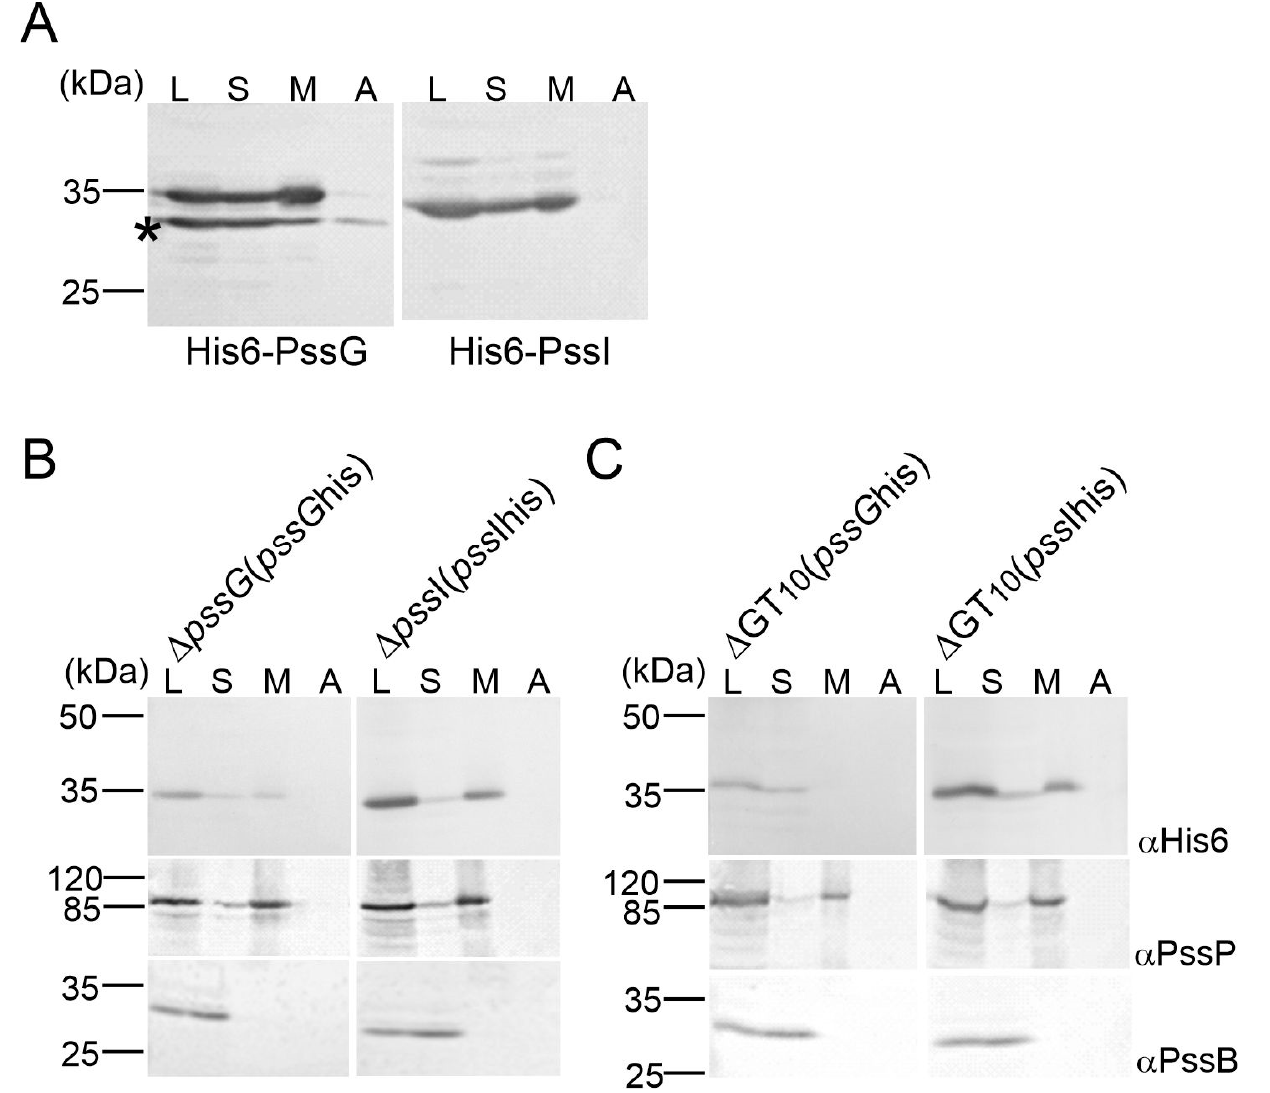
Figure 5. Study of the subcellular localization of PssG and PssI glycosyltransferases. Proteins of cell fractions obtained from E. coli M15 (pREP4) carrying pQE-30-based expression constructs ( A ), ∆ pssG and ∆ pssI mutants complemented with plasmids carrying pssG and pssI with a histidine-tag ( B ), and mutant ∆ GT 10 carrying the same complementation plasmids ( C ), were separated in SDS-PAGE and subjected to Western blotting with the following antibodies: anti-His 6 (localization of tested proteins), anti-PssP (IM protein), and anti-PssB (cytoplasmic protein). The experiment was repeated twice with the same result. An asterisk (*) in ( A ) indicates protein species reactive with anti-His 6 antibodies with an MW lower than calculated for PssG—probably shortened translation variant. L—cleared lysate; S—soluble proteins; M—membranes; A—membrane-associated proteins. Our analyses confirmed that C-terminal 50–60 amino acids in both proteins form at least 2–3 stretches that may fold into amphipathic α -helices, with hydrophobic amino acids on one side and polar and charged amino acids on the opposite side. This specific organiza- tion represented on the helical wheels is nicely complemented by the ConSurf graphical results, where the amino acids in the predicted amphipathic stretches are organized in a typical pattern of 2–4 buried residues interwoven with 1 exposed residue (Figure